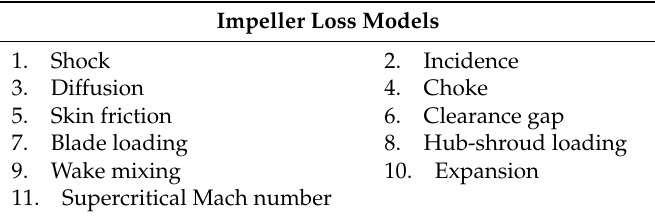
Table 3. Impeller loss models used for the study